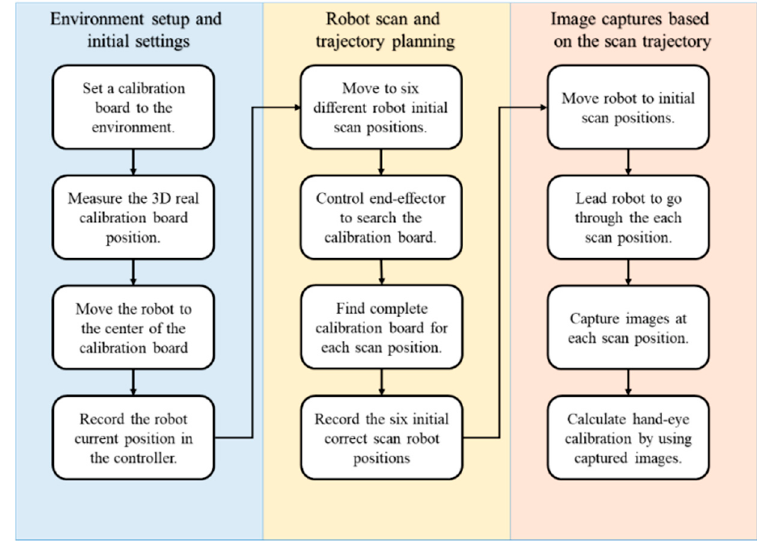
Figure 2. Flowchart of the hand–eye calibration methodology.